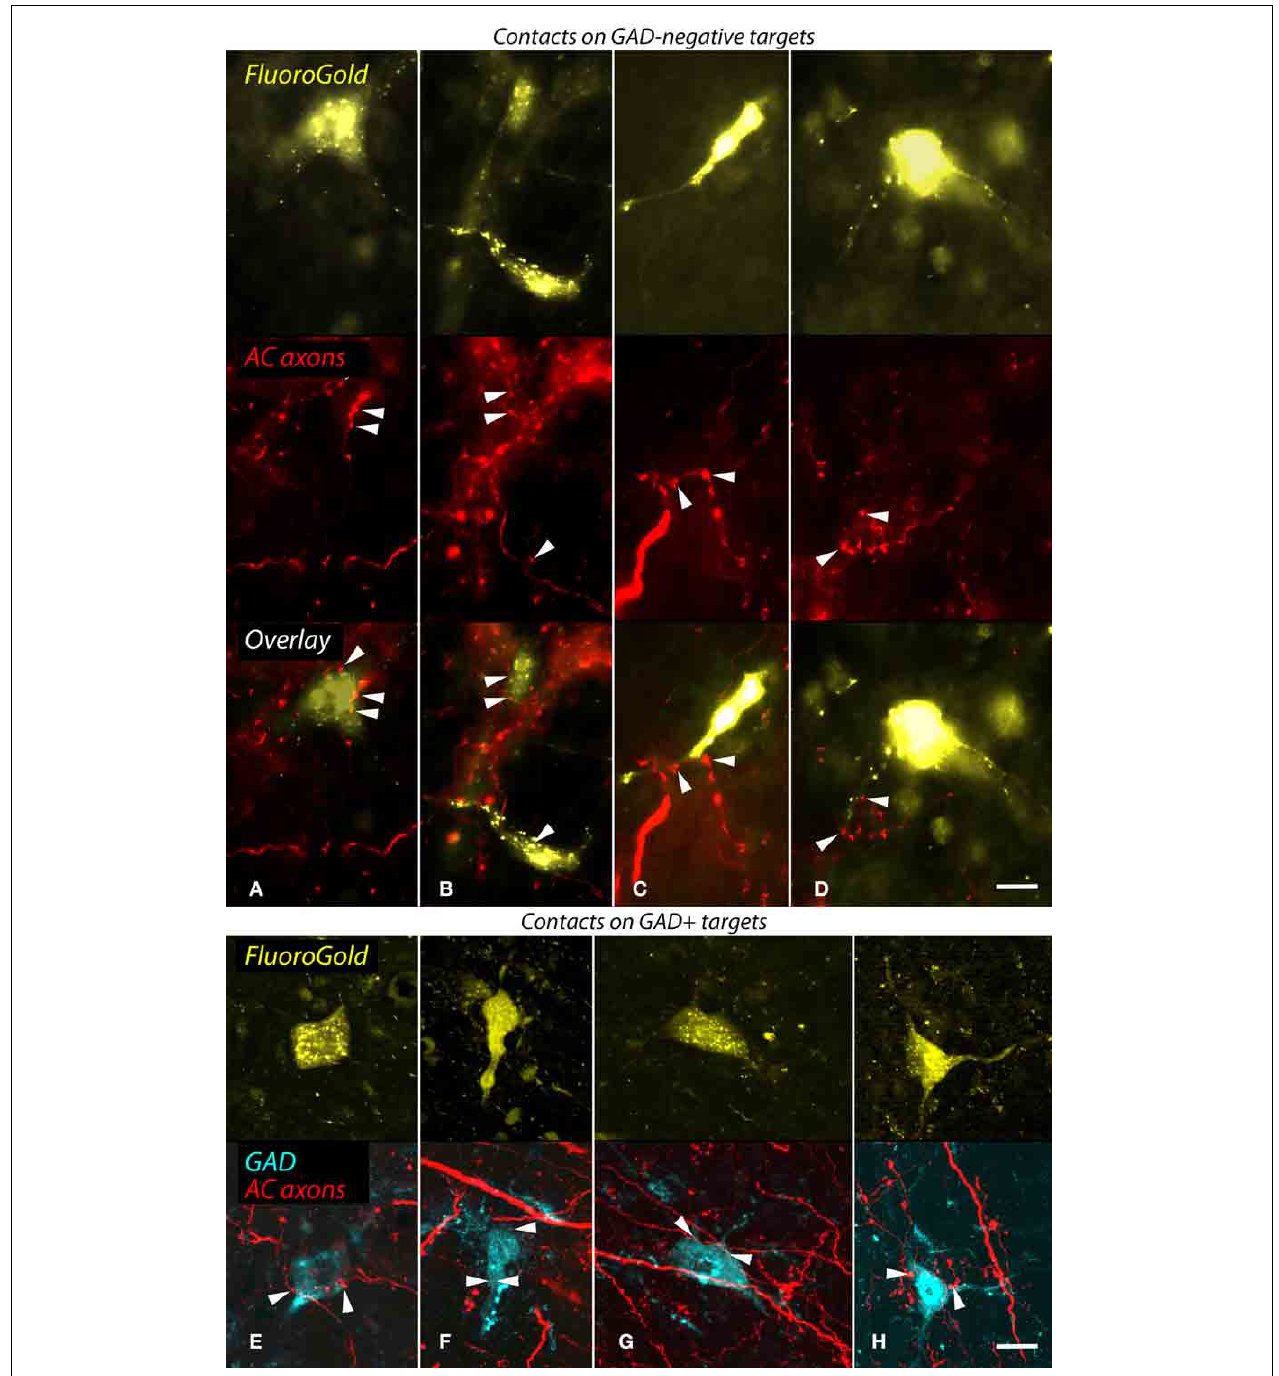
FIGURE 6 | Structured illumination fluorescence micrographs showing FluoroGold (FG)-labeled GAD-negative and GAD + cells in the nucleus of the brachium of the inferior colliculus (NBIC) that project to the medial geniculate nucleus (MG) and appear to receive synaptic inputs from FluoroRuby (FR)-labeled auditory cortical (AC) axons. (A–D) Cortical contacts on GAD-negative cells. In each column, the top image shows NBIC cells labeled by an injection of FG into the ipsilateral MG. The middle panel shows the same area visualized for axons labeled by an injection of FR into the ipsilateral AC. The bottom panel shows an overlay of the images, with